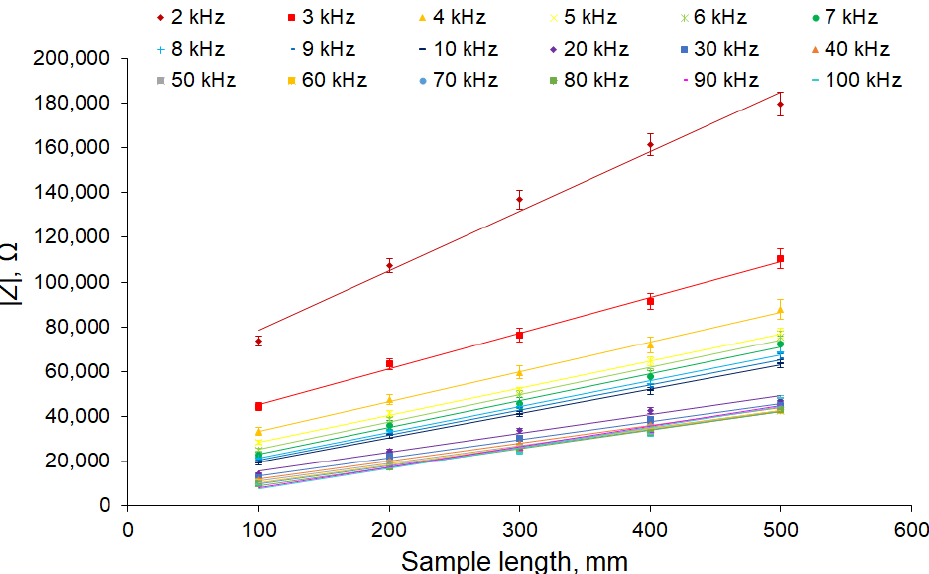
Figure 7. Dependence of the impedance modulus on the length of the sample for different frequencies after compensation of the capacitive transition of the electrodes. The apple tree was 23 mm in diameter. The number of samples is 5 and the number of measurement repetitions was 5. Data are presented as mean values and standard errors.